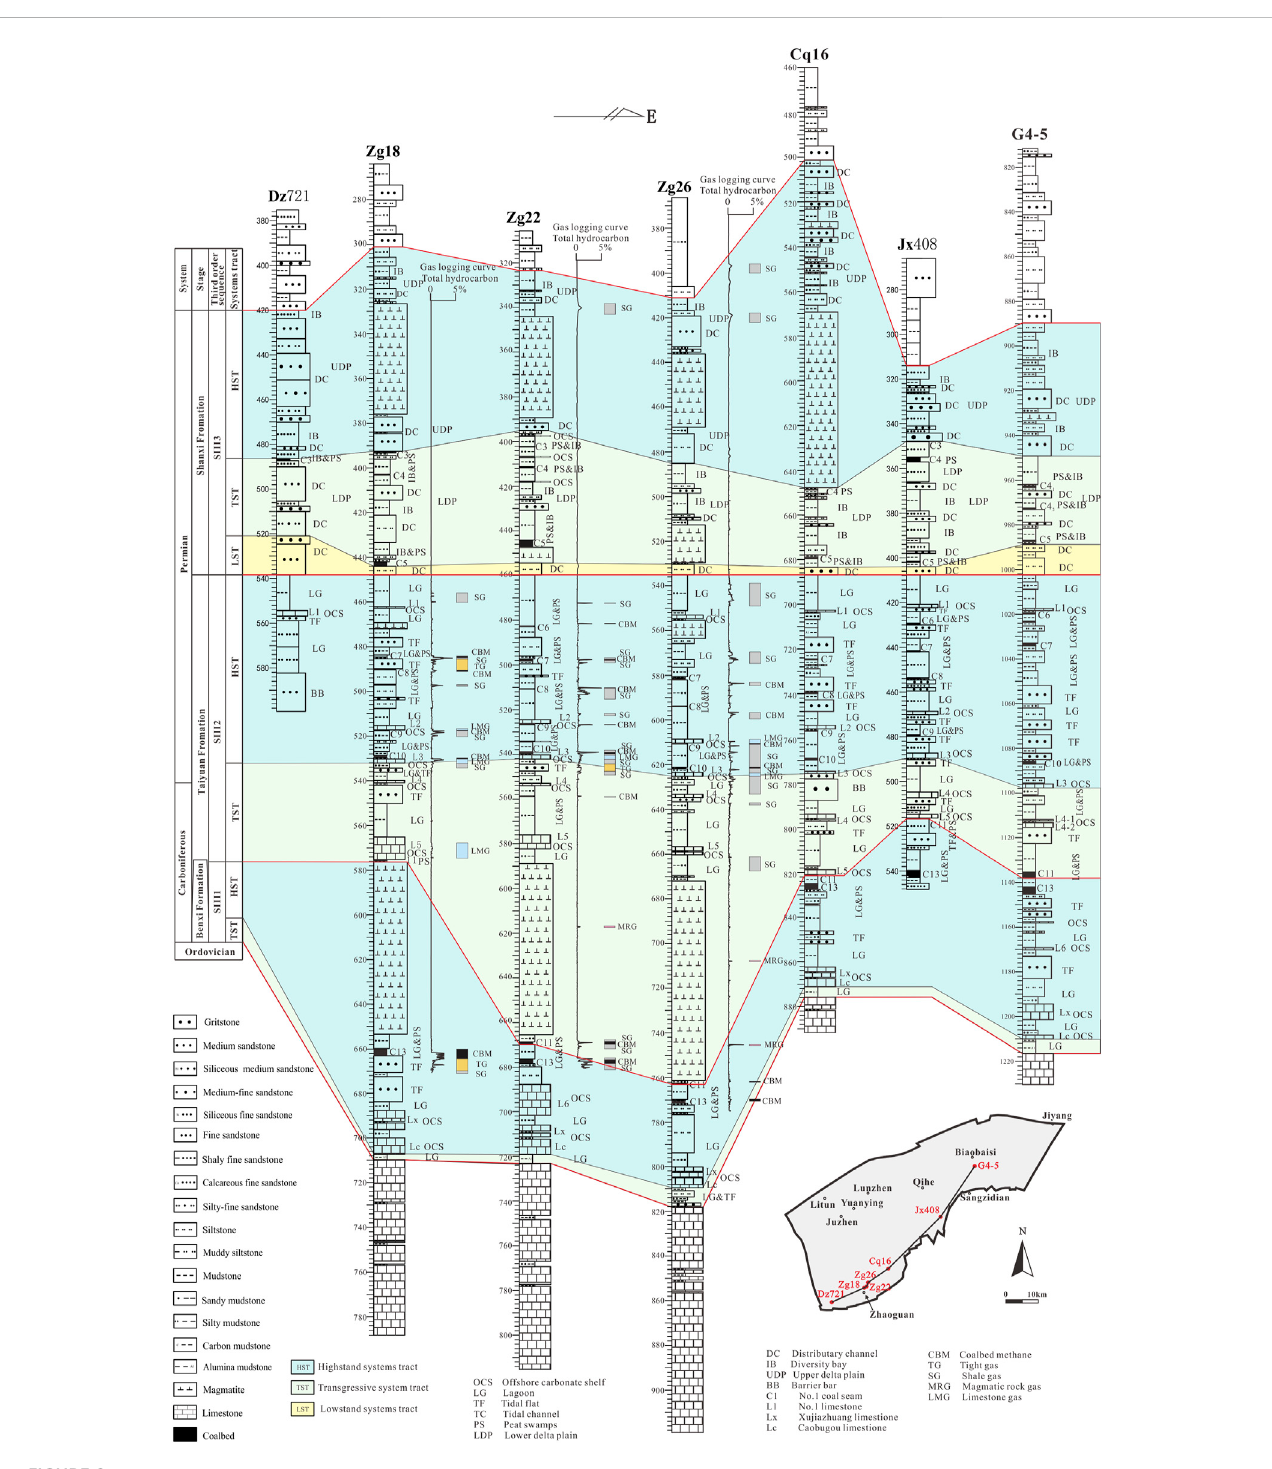
FIGURE 2 Correlation diagram of the sedimentary facies and sequence stratigraphy (SW ‒